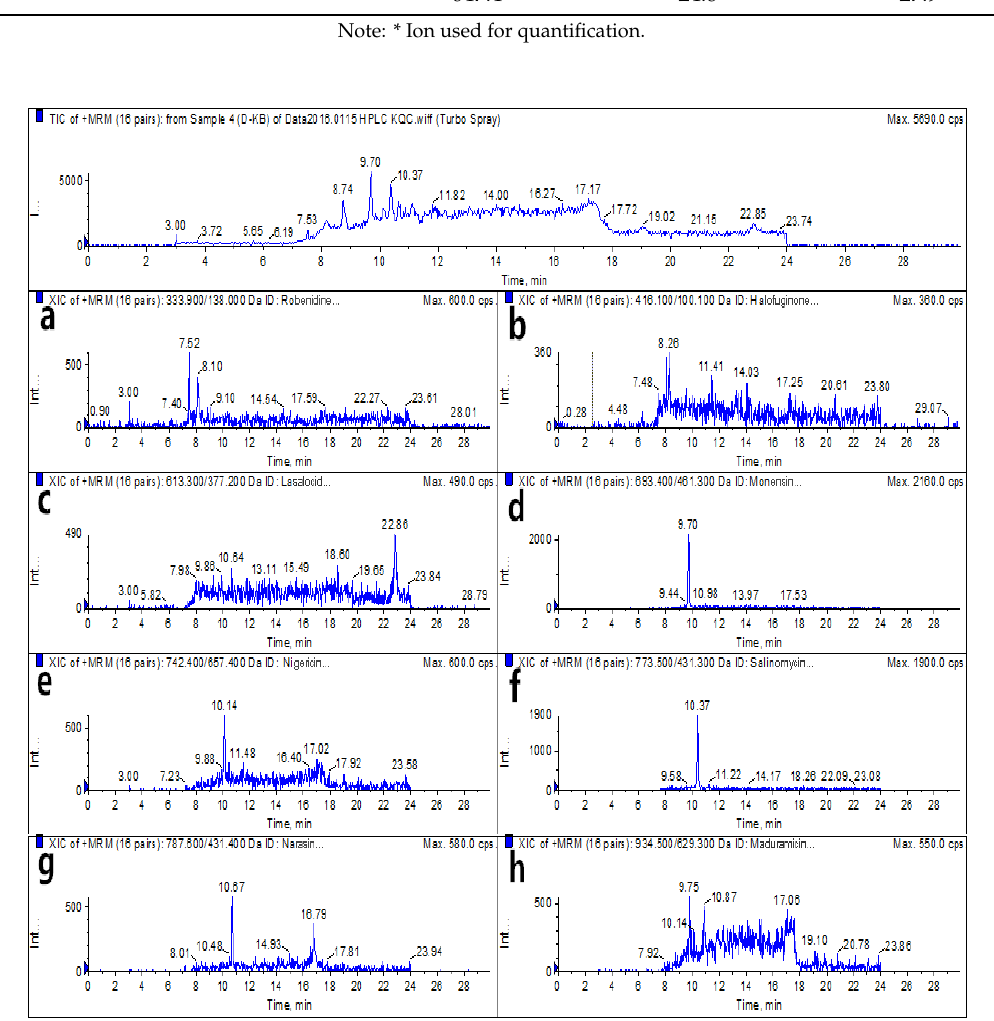
Figure 2. HPLC–MS/MS total ion chromatograms (TICs) and extracted ion chromatograms (XICs) ( a